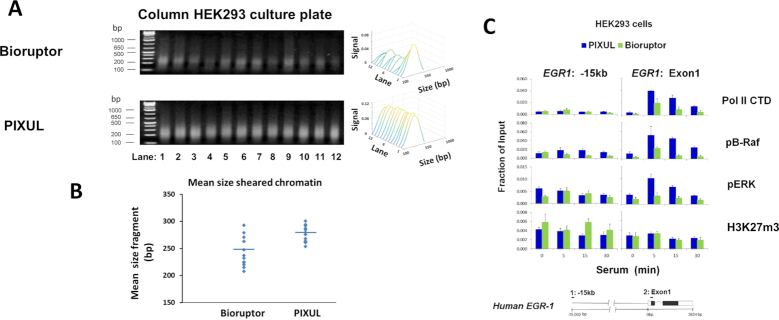
Matrix ChIP analysis of chromatin prepared from 96-well HEK293 cultures using PIXUL and Bioruptor. Serum-deprived HEK293 96-well cultures were treated with serum for 0, 5, 15 and 30 min. Cells were crosslinked directly in the 96-well plate, harvested manually from Row A (12 samples) and transferred to twelve 0.5 ml tubes for ultrasound treatment in the Bioruptor (45 min). The rest of the plate was sealed and sonicated in PIXUL (26 min treatment). (A) comparison of sheared chromatin fragments obtained with Bioruptor versus PIXUL analyzed by agarose gel electrophoresis, Ethidium bromide stained gels are shown, sizes (bp) of DNA ladder fragments (first lane) are shown to the left. Sonicated fragments were analyzed by image analysis software (Methods), results are displayed as waterfall plots in sequential order of samples run from lane 1 to 12. X- axis; band size in base pair (bp). Y-axis; sample from a given lane. Z-axis; relative signal intensity of bands. (B) Mean fragment size (each blue dot) of sheared chromatin obtained with Bioruptor and PIXUL. (C) Sheared chromatin samples from both PIXUL and Bioruptor were analyzed simultaneously by Matrix ChIP using antibodies to Pol II, pB-Raf, pErk and H3K27m3. ChIPed DNA was analyzed by real-time PCR using indicated primers. Results show mean ± SEM (n = 3 replicates for each time point for each instrument). This comparison demonstrates that sample transfer causes significant sample losses, which may in part account for greater variability. There are lower Matrix ChIP signals from chromatin prepared with Bioruptor compared to PIXUL.